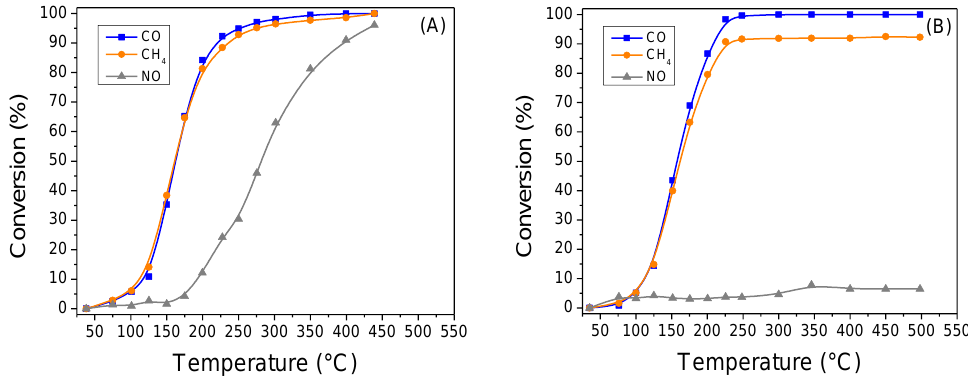
Table 4. T50 and maximum efficiency values for the abatement of CO, CH4 and NO, obtained for the tested catalysts.